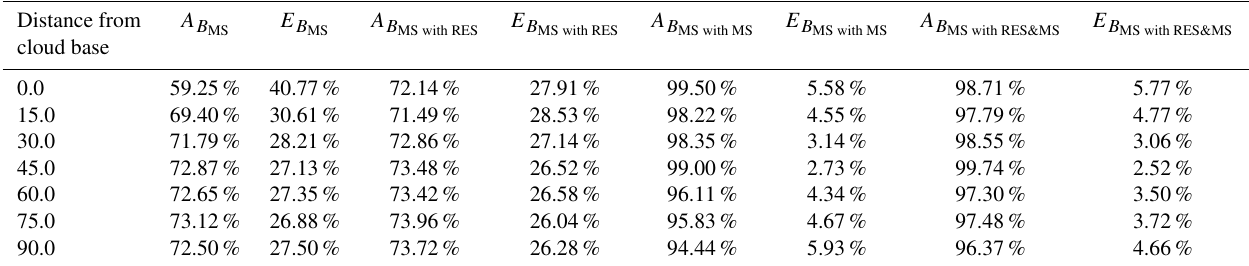
Table 2. Mean error and accuracy of the cloud optical thickness extinction retrieval for different heights above the cloud base. Data are re- trieved by inverting the simulated multiple scattering signal ( B MS ) with the α 0 estimate calculated from Eq. (7). Results from four inversions are presented, i.e. one without any correction, one with the application of the resolution correction calculated from Eqs. (12) and 14 (denoted with the subscript RES), one with the multiple scattering correction calculated from Eq. (8) (denoted with the subscript MS), and the last one with both the resolution and the multiple scattering correction (denoted with the subscript RES&MS).